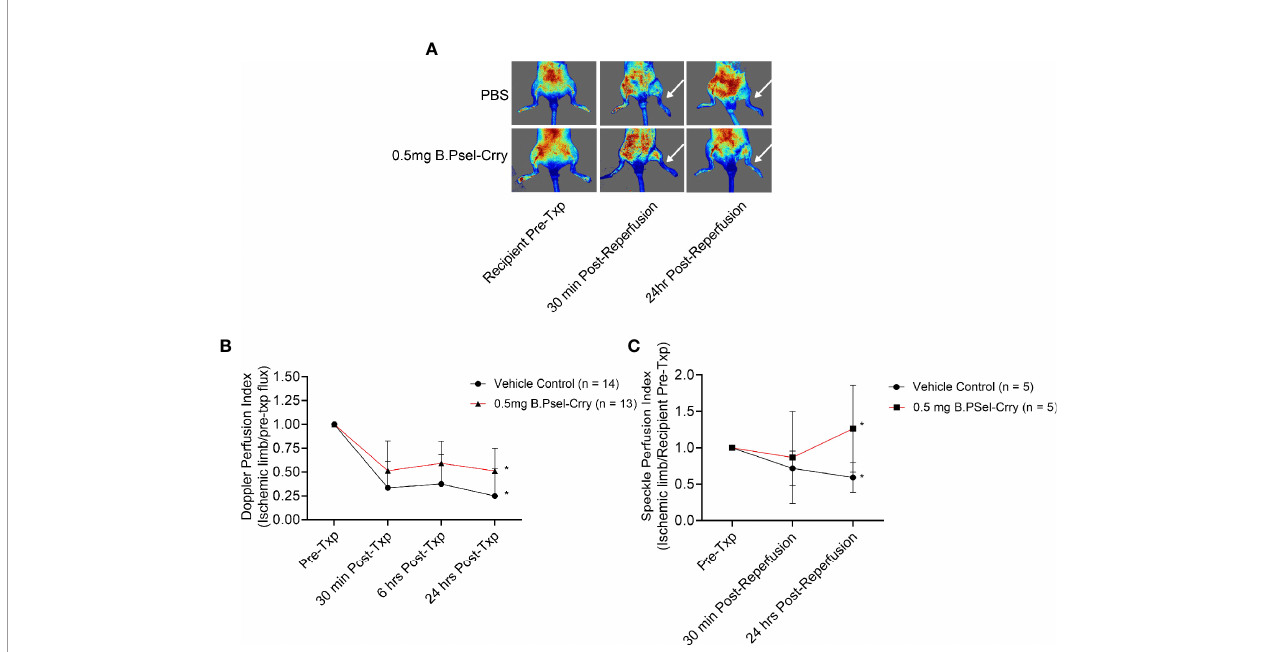
FIGURE 6 | B.PSel-Crry improves hindlimb perfusion at 24 hours post-transplantation in a vascularized composite isograft. Hindlimb transplanted recipients were treated immediately post-reperfusion as indicated and perfusion measured in the graft paw by conventional laser Doppler fl ow and laser speckle Doppler imaging at indicated time points after transplantation. (A) Representative Laser speckle Doppler images. (B) Quanti fi cation of perfusion by conventional laser Doppler fl ow. T- test. (C) Quanti fi cation of perfusion by Laser speckle doppler. T-test. Perfusion was signi fi cantly improved at 24 hours post-transplantation following 0.5mg B.PSel- Crry treatment. Data expressed as Mean ± SD; *p ≤ 0.05. n = as indicated in fi gure.